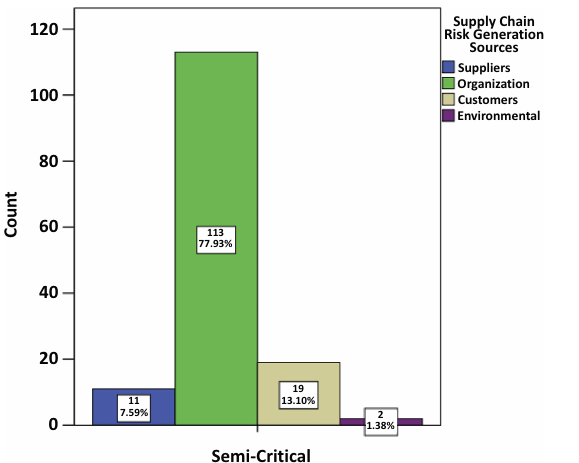
Figure 10. The contribution of each supply chain resource generation source to the production of